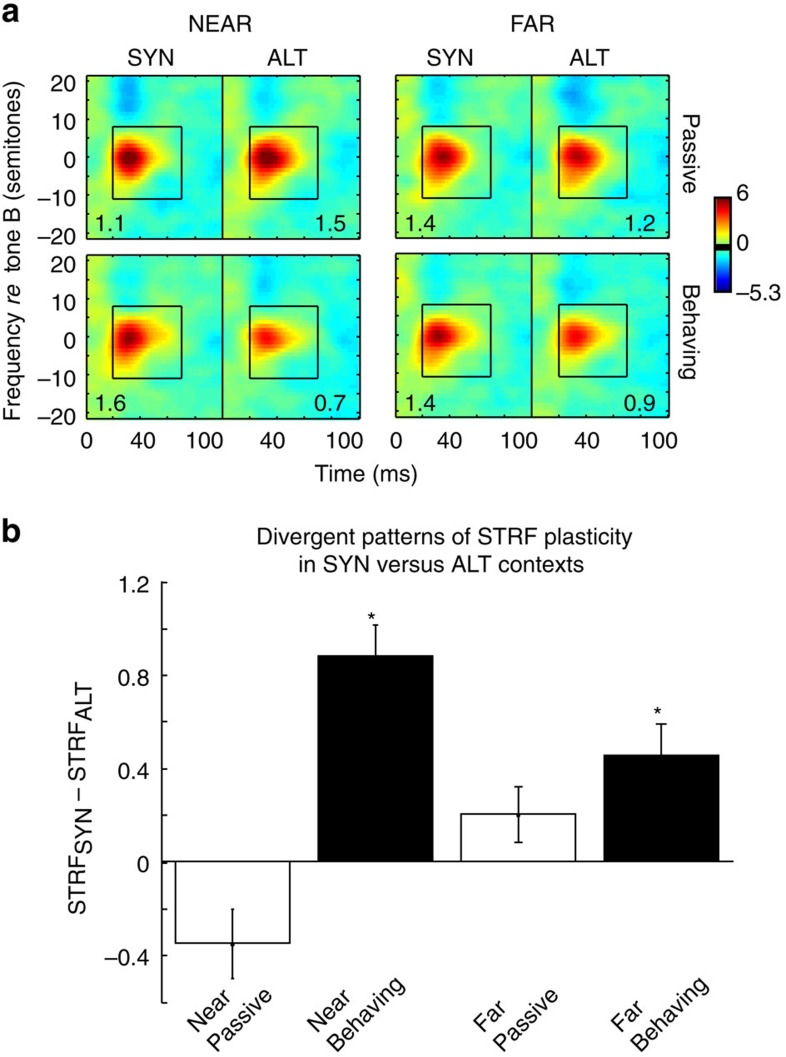
Dependence of STRF changes on sequence spectral separation across all cells.(a) Changes in averaged STRFs in SYN and ALT contexts obtained from units with small (NEAR) and large (FAR) spectral separation (ΔF) (left and right pairs of panels, respectively), both in the passive (top) and behaving (bottom) conditions. The same colour-scale is used for all STRFs. As before, STRFs following SYN and ALT contexts exhibited divergent patterns of plasticity in the behaving relative to passive states. (b) The average difference of STRF peak amplitudes following SYN versus ALT contexts (STRFSYN-STRFALT) for NEAR and FAR conditions, each for passive and behaving conditions. Bars indicate that STRF changes between SYN versus ALT contexts (STRFSYN-STRFALT) are significant for both NEAR and FAR conditions (indicated by stars, P<0.01 for both), but only during behaviour. Error bars indicate standard error.